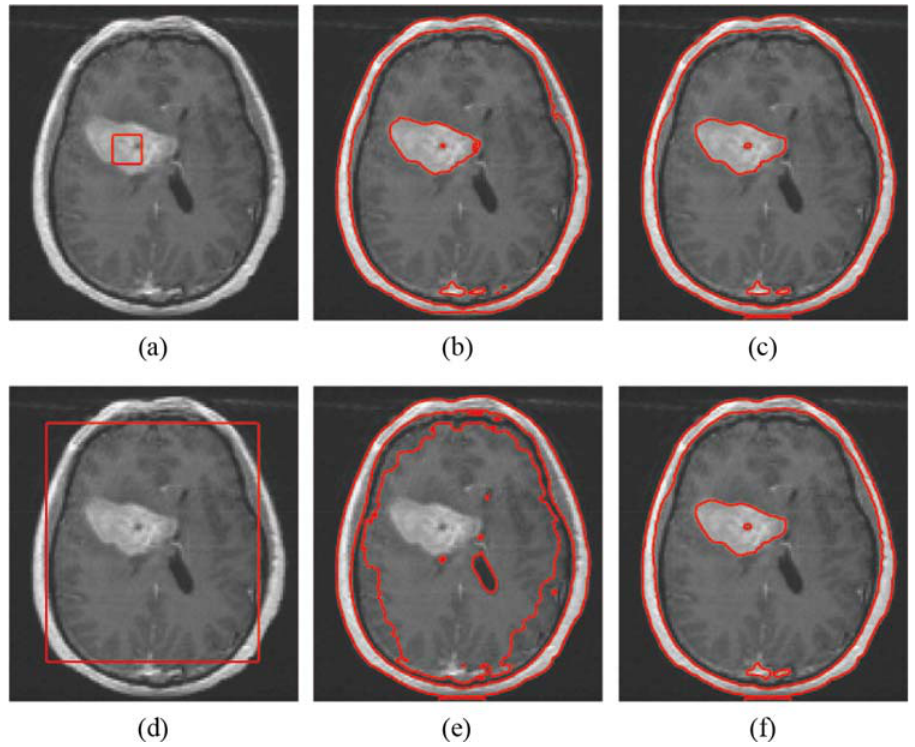
Fig 8. Comparisons of the segmentation results for a MR brain image contains tumor with intensity inhomogeneity between Li ’ s model and our model. (a), (d) The original image with initial contours. (b), (e) The results of Li ’ s model. (c), (f) The results of our